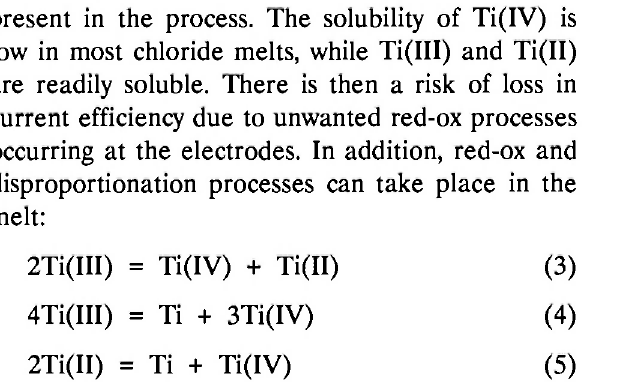
Fig. 1: The Dow-Howmet cell for electrowinnirig of titanium /6/. melting LiCl-KCl eutectic (~ 520°C) was